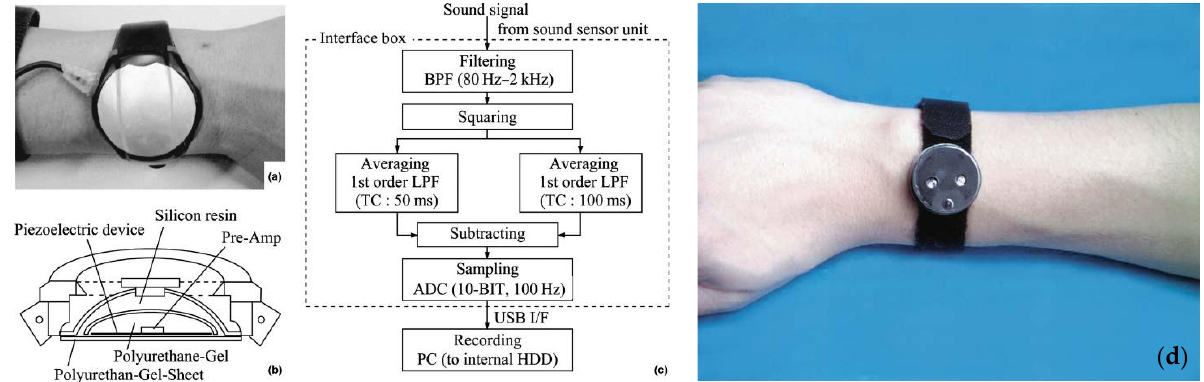
Figure 7. Examples of actigraphy sensors for scratch detection. ( a – c )—Photograph, schematic and flow chart of the acoustic scratch detection sensor by Noro et al.; ( d ) photograph of the MicroMini Motionlogger ® to showcase its compactness and non-invasiveness. Images reproduced with permissions from [22,78].